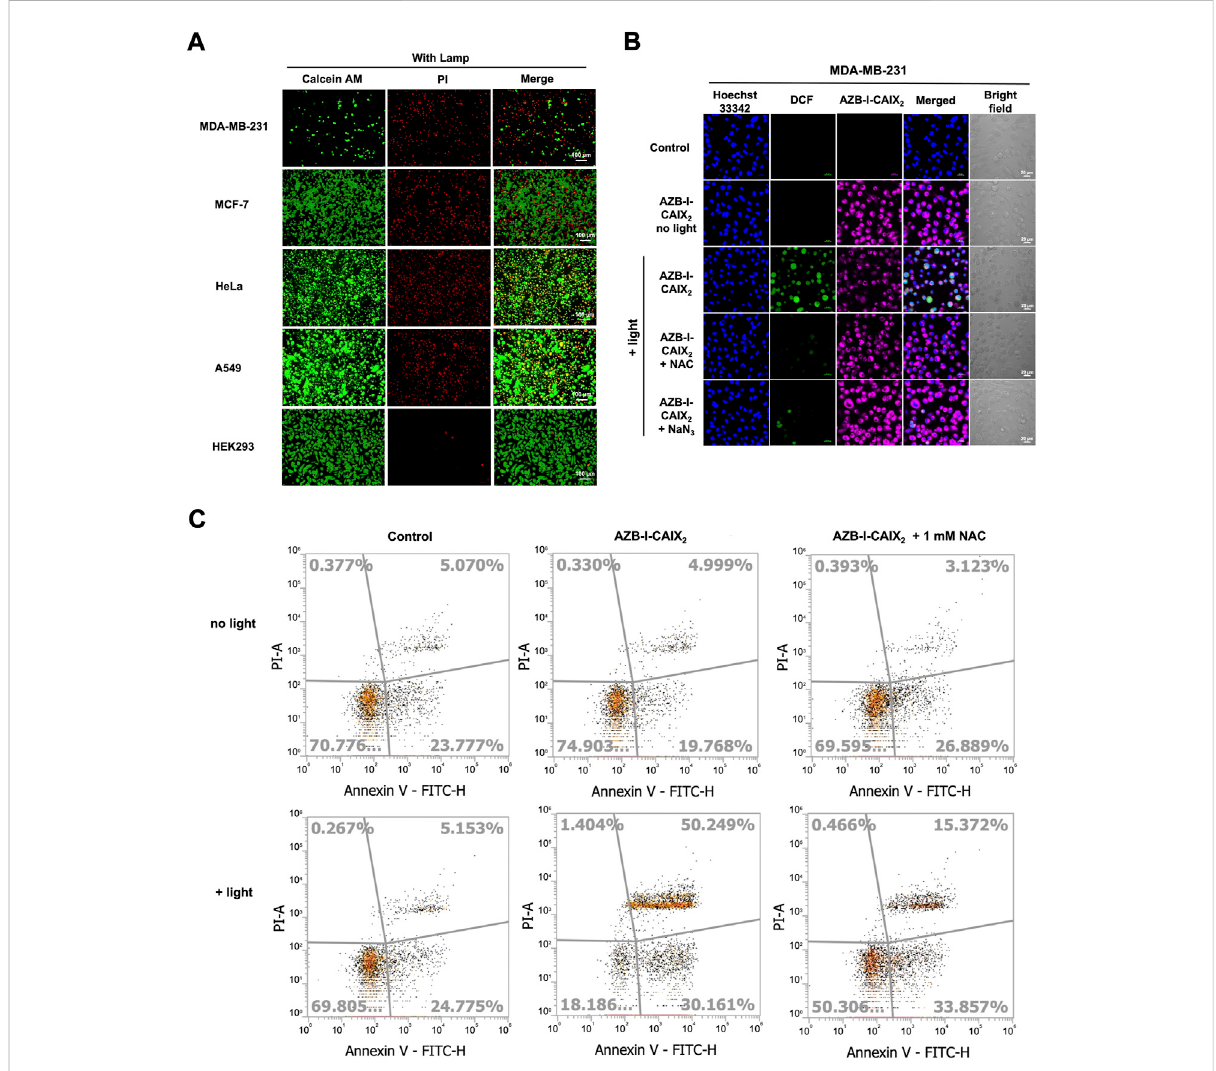
Viability/Cytotoxicity assay and intracellular ROS detection. (A) Live/dead cell imaging of CAIX+ (MDA-MB-231) and CAIX- (MCF-7, HeLa, A549,